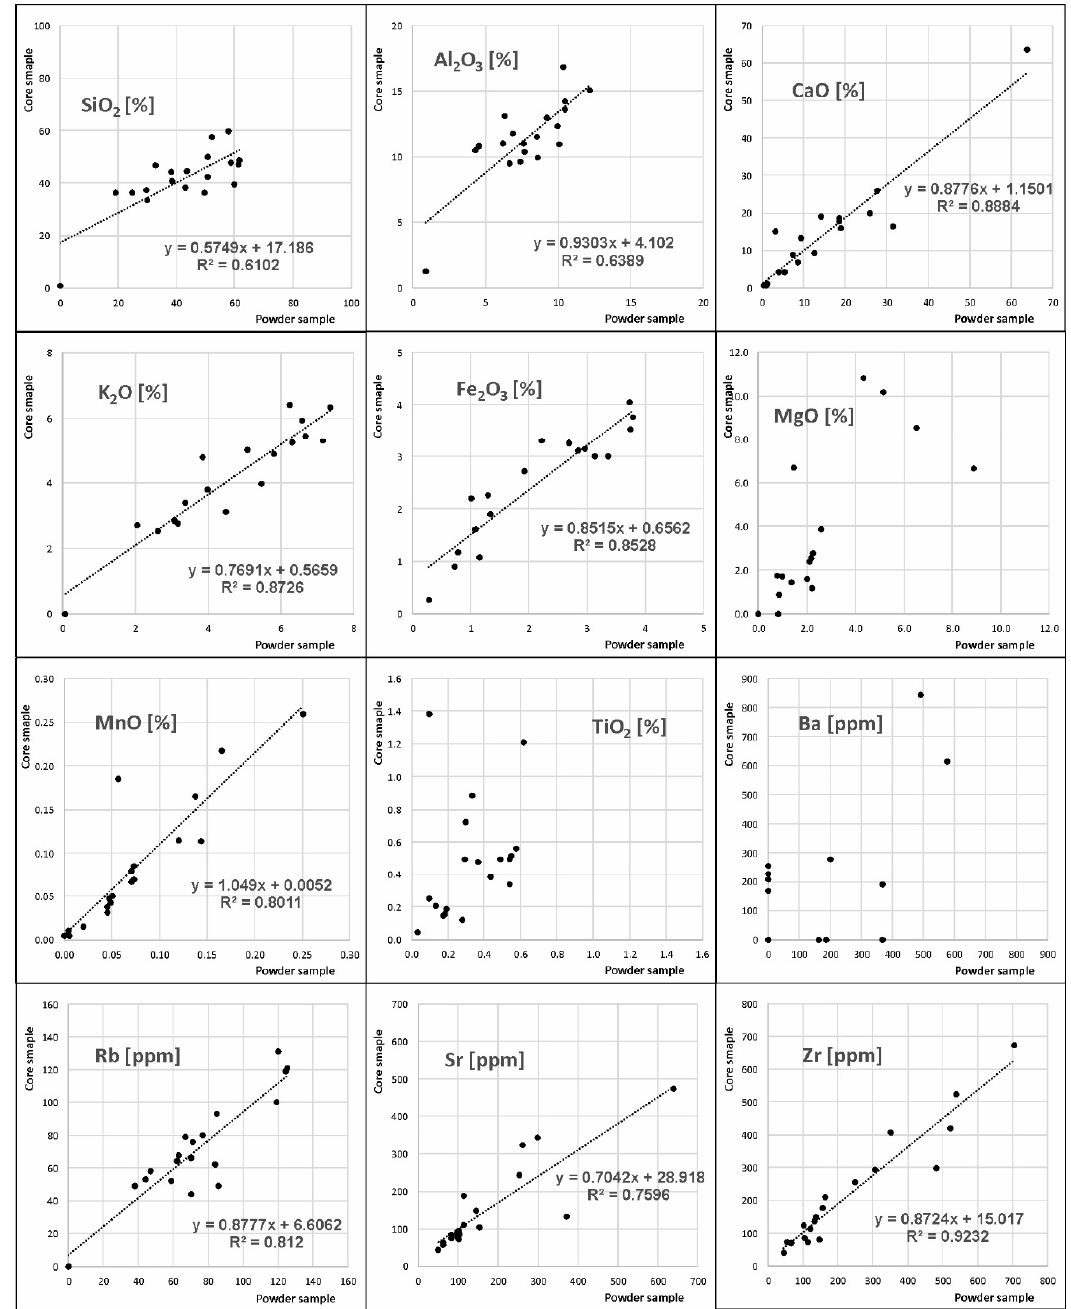
Figure 7. Correlation of chemical composition analysis results obtained in the INIG-PIB on solid and ground samples for the Biesiekierz-2 borehole.